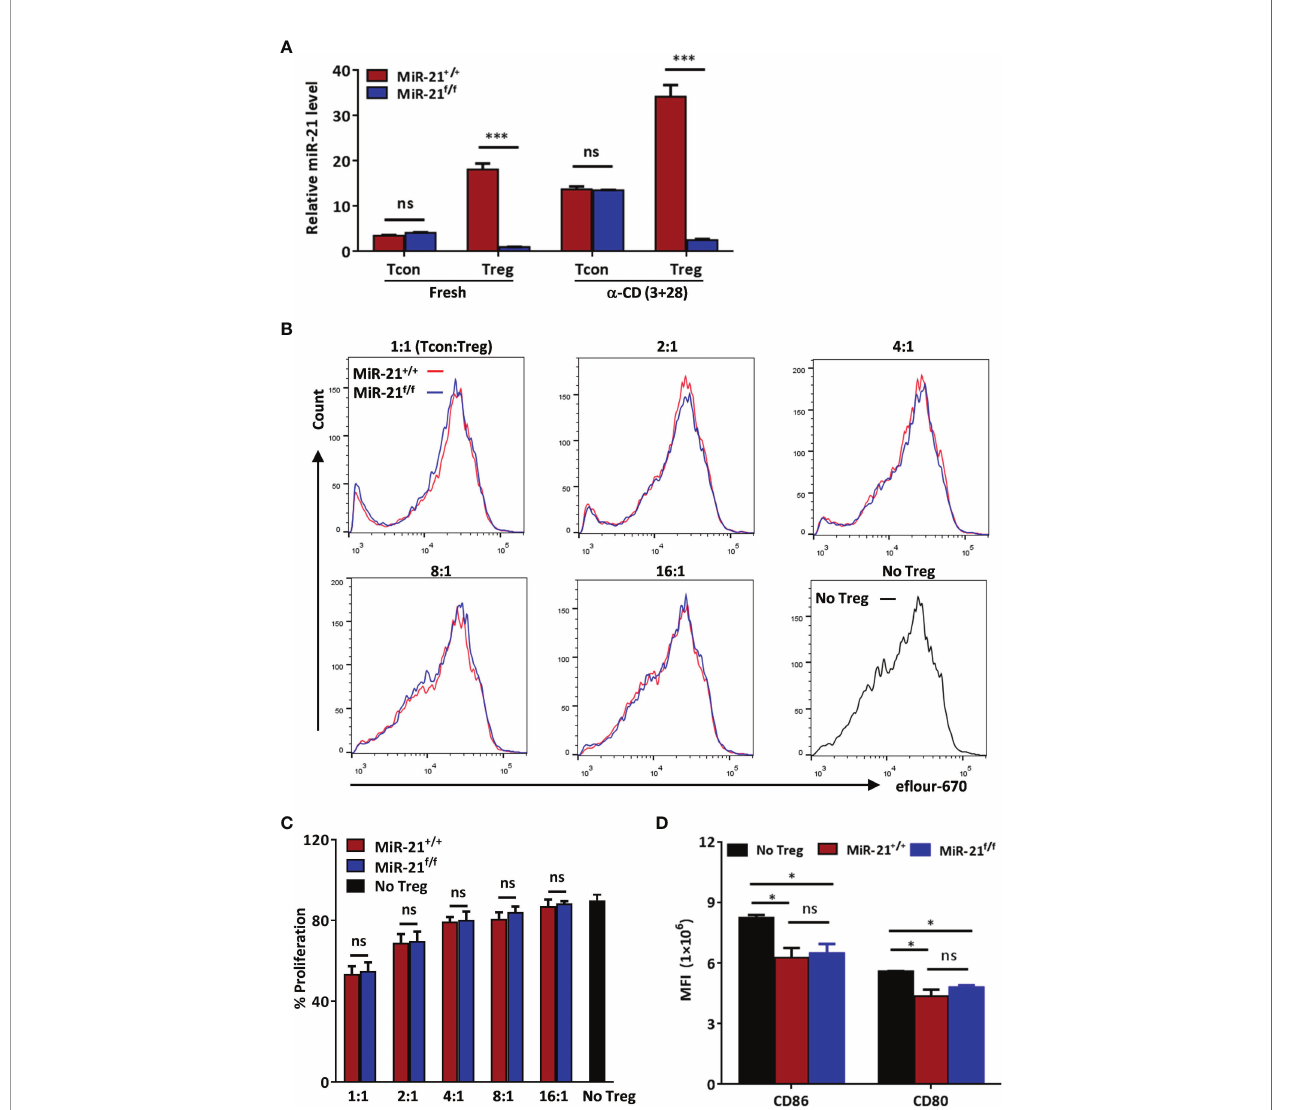
FIGURE 1 | MiR-21 de fi ciency doesn ’ t affect the immune-suppressive function of Treg cells in vitro . (A) Deletion of miR-21 in both rested Treg (rTreg) and activated Treg (aTreg) was con fi rmed by RT-PCR. CD4 + CD8 - YFP - (Tcon) and CD4 + CD8 - YFP + (Treg) were fl ow sorted from the spleen of Foxp3 Cre-YFP miR-21 +/+ (MiR-21 +/+ ) and Foxp3 Cre-YFP miR-21 f/f (MiR-21 f/f ) mice (n=5). Cells were either untreated or treated with a -CD3 plus a -CD28 for 24 h, and miR-21 level was determined by quantitative RT-PCR. (B, C) Flow sorted splenic CD4 + CD8 - YFP + cells from Foxp3 Cre-YFP miR-21 +/+ (MiR-21 +/+ ) and Foxp3 Cre-YFP miR-21 f/f (MiR-21 f/f ) mice (n=3) were mixed with eFluor-670-labeled naïve CD4 + T cells at indicated ratio and incubated with mouse T-Activator CD3/CD28 beads. After 72 h, dilution of eFluor-670 was examined by fl ow cytometry. The histogram (B) and quanti fi cation (C) of the proliferating T cells were shown. (D) BMDCs were cultured alone or mixed with fl ow sorted splenic CD4 + CD8 - YFP + cells from either Foxp3 Cre-YFP miR-21 +/+ (MiR-21 +/+ ) or Foxp3 Cre-YFP miR-21 f/f (MiR-21 f/f ) mice (n=3) at 1:1 ratio. Cells were then treated with anti-CD3, anti-CD28, IL-2 and LPS for 12 h. The MFI of CD80 and CD86 in BMDCs was examined by fl ow cytometry after cells were stained with fl uorescent- labeled antibodies against CD11c, CD80 and CD86. Results are representative of two to three independent experiments. MLN, mesenteric lymph node; BMDCs, bone-marrow derived dendritic cells; MFI, mean fl uorescence intensity. ns, no signi fi cance. *p < 0.05; ***p <